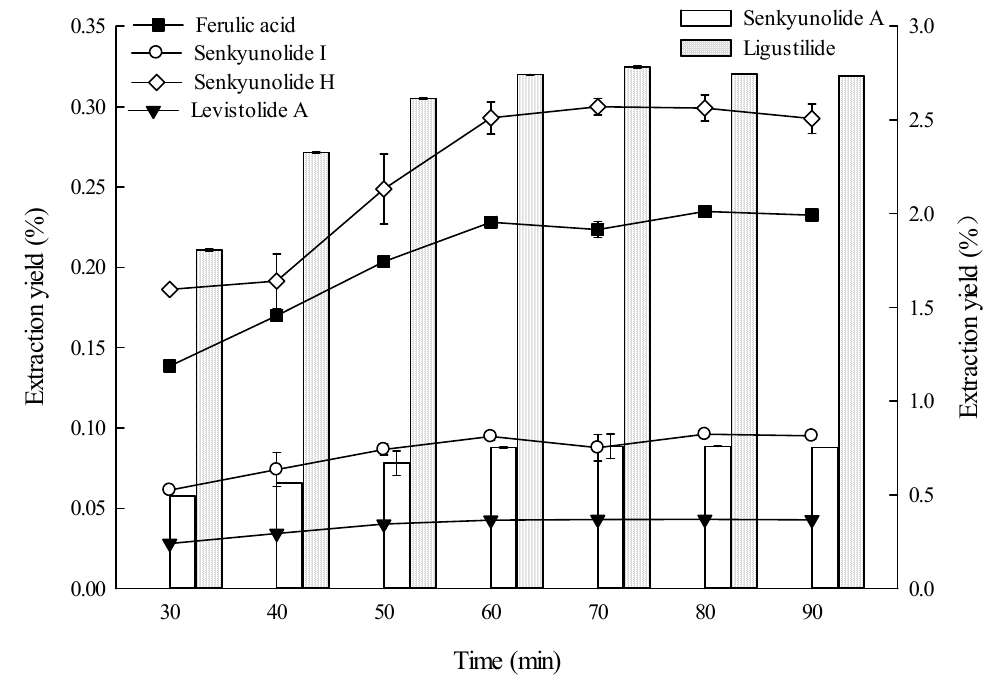
Figure 7. Effect of time on the extraction yields of the six constituents (the lines and bar graphs are referenced to the left and right axes, respectively).